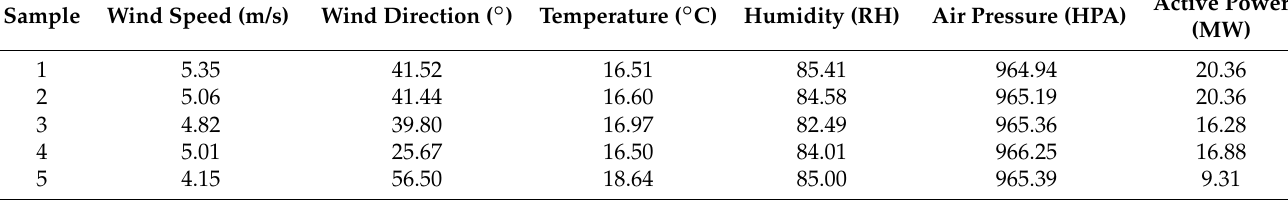
Table 1. The dataset’s first five groups of